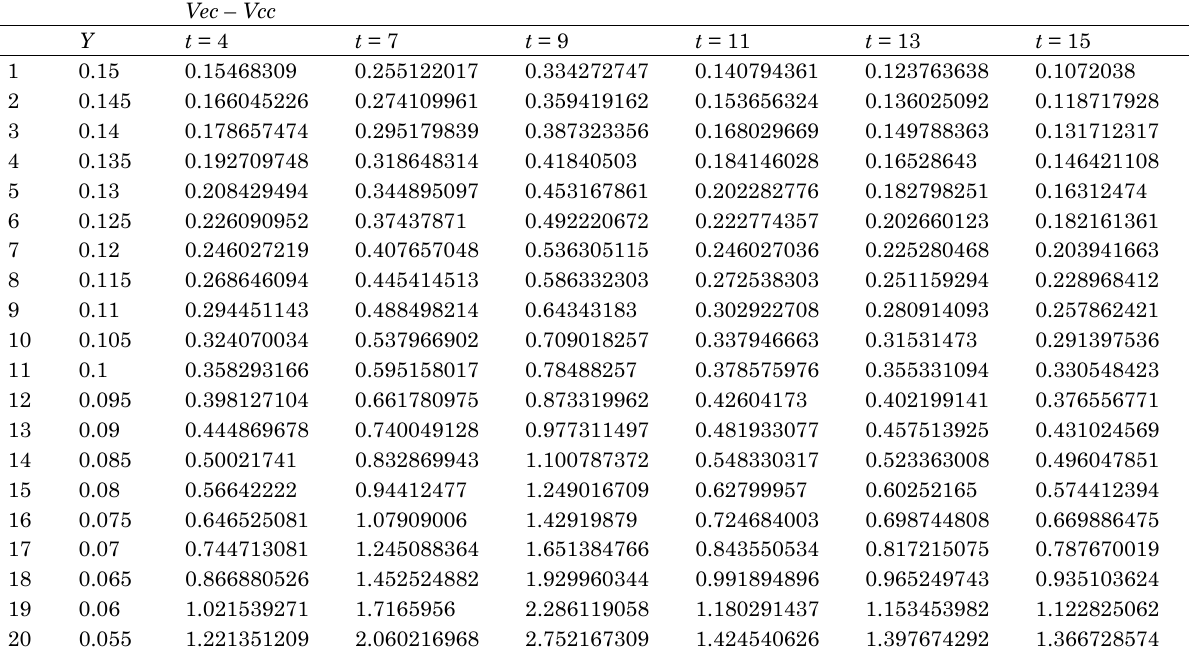
table 8. comparison between the DD model in expansion contraction phase of the market and cyclical capitalization for different temporal lengths of the market